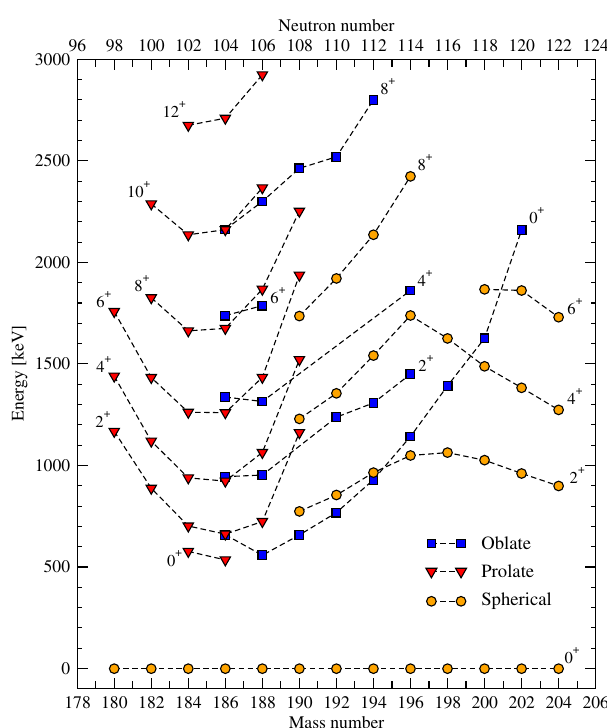
Fig. 8 Adapted level energy systematics of the neutron-de fi cient even- mass Pb nuclei. The different predominant intrinsic con fi gurations have been labelled and connected with dashed lines. Data are from the present work and refs. 4